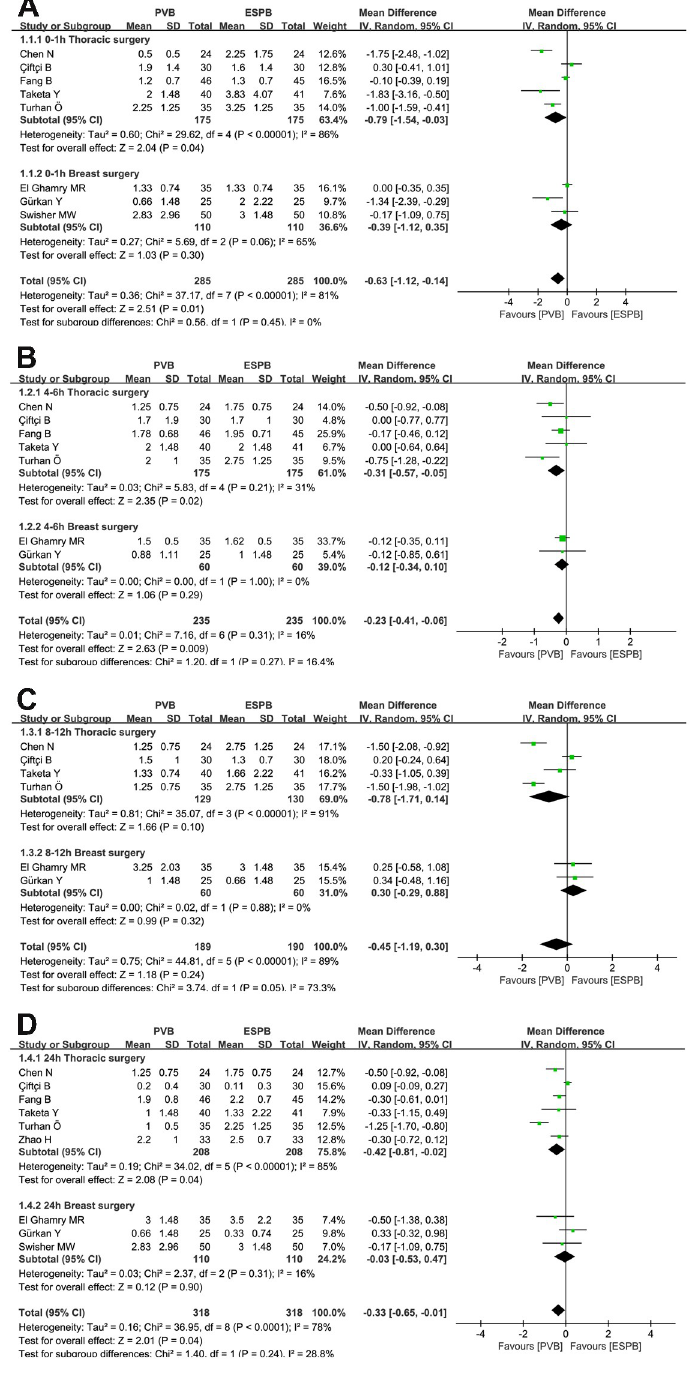
Fig 5. Forest plot of the subgroup analysis of postoperative scores for resting pain at 0–1 hours (A), 4–6 hours (B), 8–12 hours (C) and 48 hours (D).